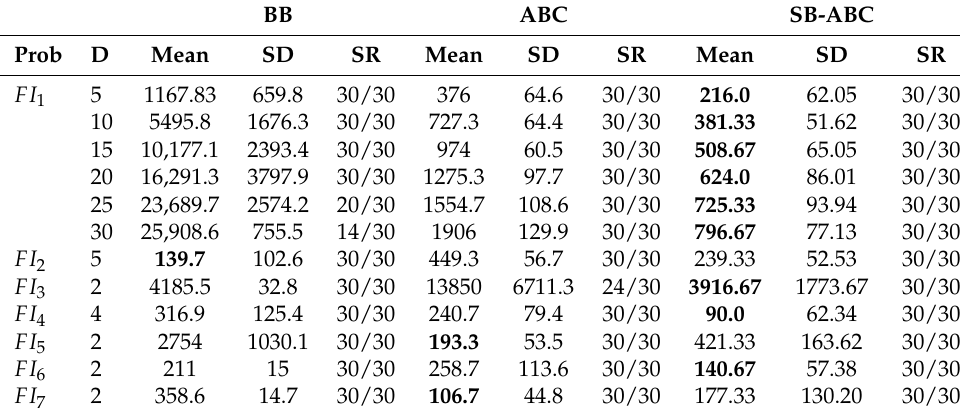
Table 2. Comparison results of the BB method, ABC and SB-ABC for the FI 1 – FI 7 integer program- ming problems.